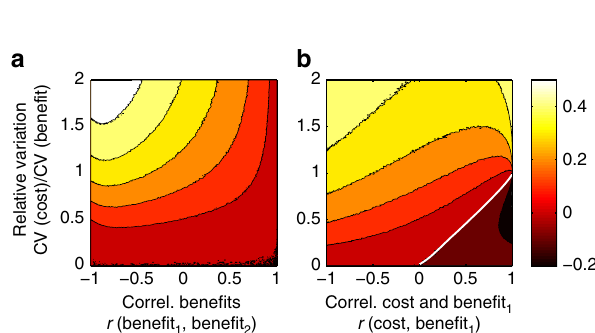
Fig. 2 Simulation results showing the mean change in agreement levels when moving to ROI methods. The color map values show the mean change in agreement levels between two budget allocations when ranking candidate sites for protection based on ROI (bene fi t/cost) vs. when ranking them based on ecological bene fi ts only, i.e., it shows ROI Agreement − Bene fi t Agreement. The mean change in agreement levels across 2000 replicate simulations is shown for each combination of correlation and relative variation parameters. Lighter colors indicate larger positive changes, for which moving to ROI prioritization results in a larger improvement in agreement levels over what locations should be